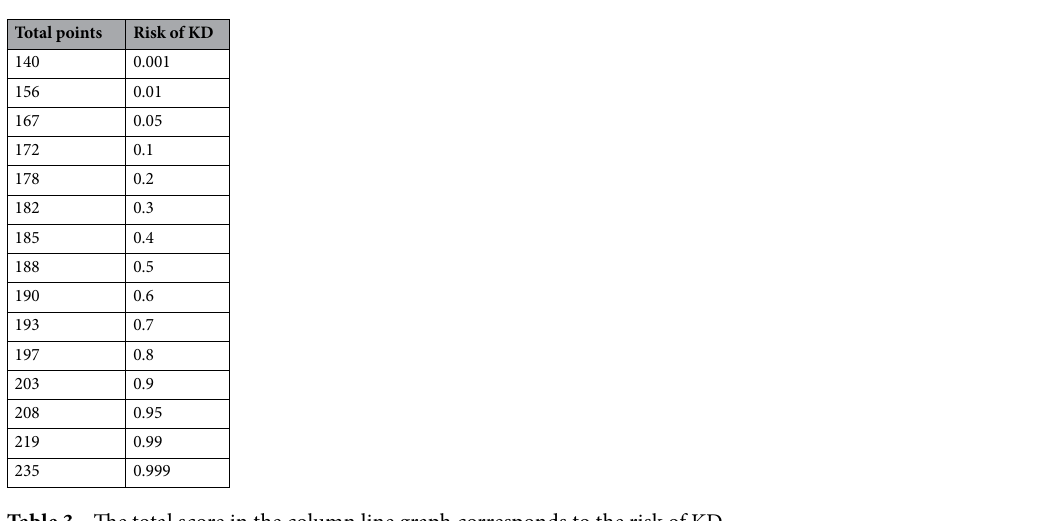
Table 3. The total score in the column line graph corresponds to the risk of